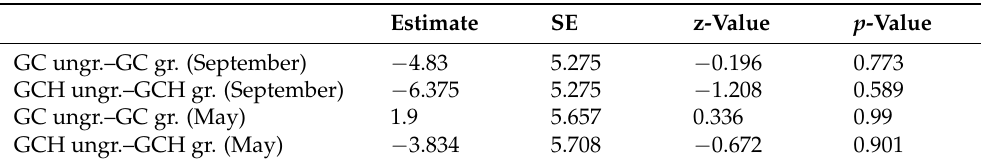
Table A31. Differences in activity densities of flying/mobile carabid beetles, comparing the grazed pastures and ungrazed strips of the grass–clover (GC) and the grass–clover herbs (GCH) in May/June and